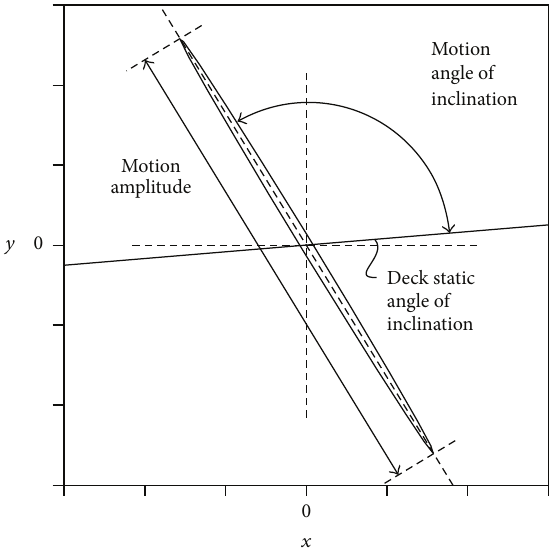
Figure 4: Motion characteristics measured in linear vibrating